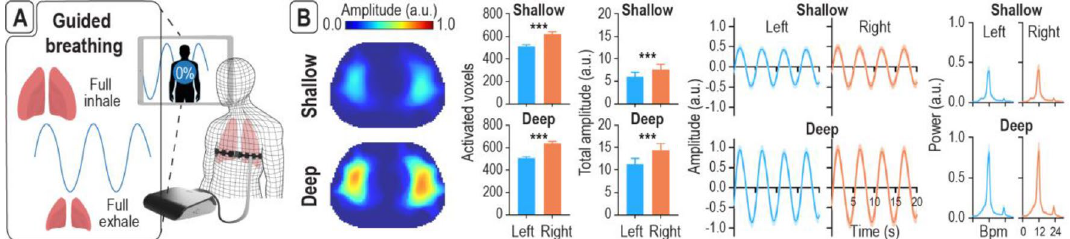
Figure 5. EIT with novel close-to-effortless guided breathing paradigm can quantify global and regional lung functional changes. ( A ) The paradigm is a periodic inhale and exhale pattern at 12 breaths per minute (bpm). ( B ) Shallow and deep breathing modes were applied to assess the sensitivity of this method. Activated voxels and total amplitude were extracted from the left and right lungs. The right lung has significantly more activated voxels and significantly higher total amplitude compared to the left. The amplitude maps, total amplitude, conductivity time curve, and frequency spectra exhibited higher amplitude during deep breathing compared to shallow breathing, while activated voxels remained similar. *** p < 0.001. Error bars indicate ± standard error of mean. Abbreviations: arbitrary unit (a.u.). The drawings of the electrode belt and the portable EIT console were made using Dassault Systemes Solidworks 2020, Luxion Keyshot 9 and Adobe Photoshop CC 2019. The drawings of the dummy person was made using Adobe Illustrator amplitude as compared to shallow breathing ( p < 0.001, Fig. 5B and Supplementary Figure S6). Note the acti- vated voxels are nearly the same for both breathing depths, the total amplitude was higher during deep breathing ( p < 0.001). However, the right lung has significantly more activated voxels ( p < 0.001) and significantly higher total amplitude ( p < 0.001) compared to the left in both shallow and deep breathing modes, likely due to the positioning of the heart within the left thorax. The normalized average conductivity in the right and left lung lobes are shown in Fig. 5B both in the time and frequency domains. The results show that the conductivity vari- ations for both lungs and breathing modes follow a periodic oscillation of twelve periods per minute with lower amplitude for shallow breathing. These results demonstrated that this novel close-to-effortless guided breathing paradigm can reflect both global and regional lung function changes.